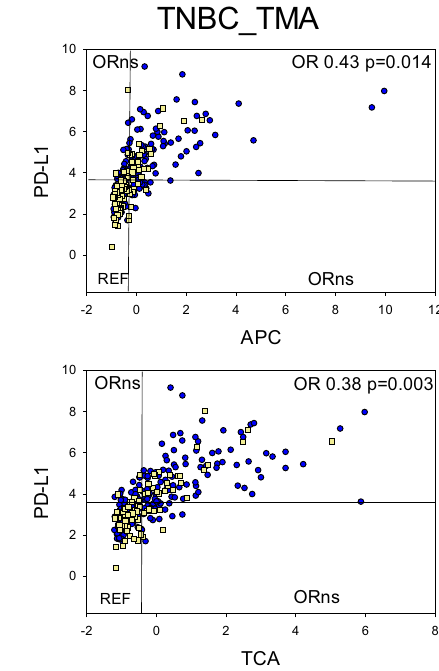
Fig.3|RecurrenceinFinXXandMayoClinicTNBC_TMAcohortsasafunctionof PD-L1 protein abundance and the APCorTCA eigenprotein scores. Eachdot or square represents tumor-average values for each feature in each tumor, including tumors thatrecurred (yellow squares) and tumorsthatdid not recur (blue circles). The X axis contains numerical scores for the APC or TCA eigenproteins, and the Y axis contains PD-L1 protein log2 normalized counts for intraepithelial segments. Odds ratios (ORs) for 5-year recurrence were calculated as dichotomous variables (recurrenceYESorNO).The reference linesindicate the population median values for each feature, and ORs were calculated in reference to samples that were